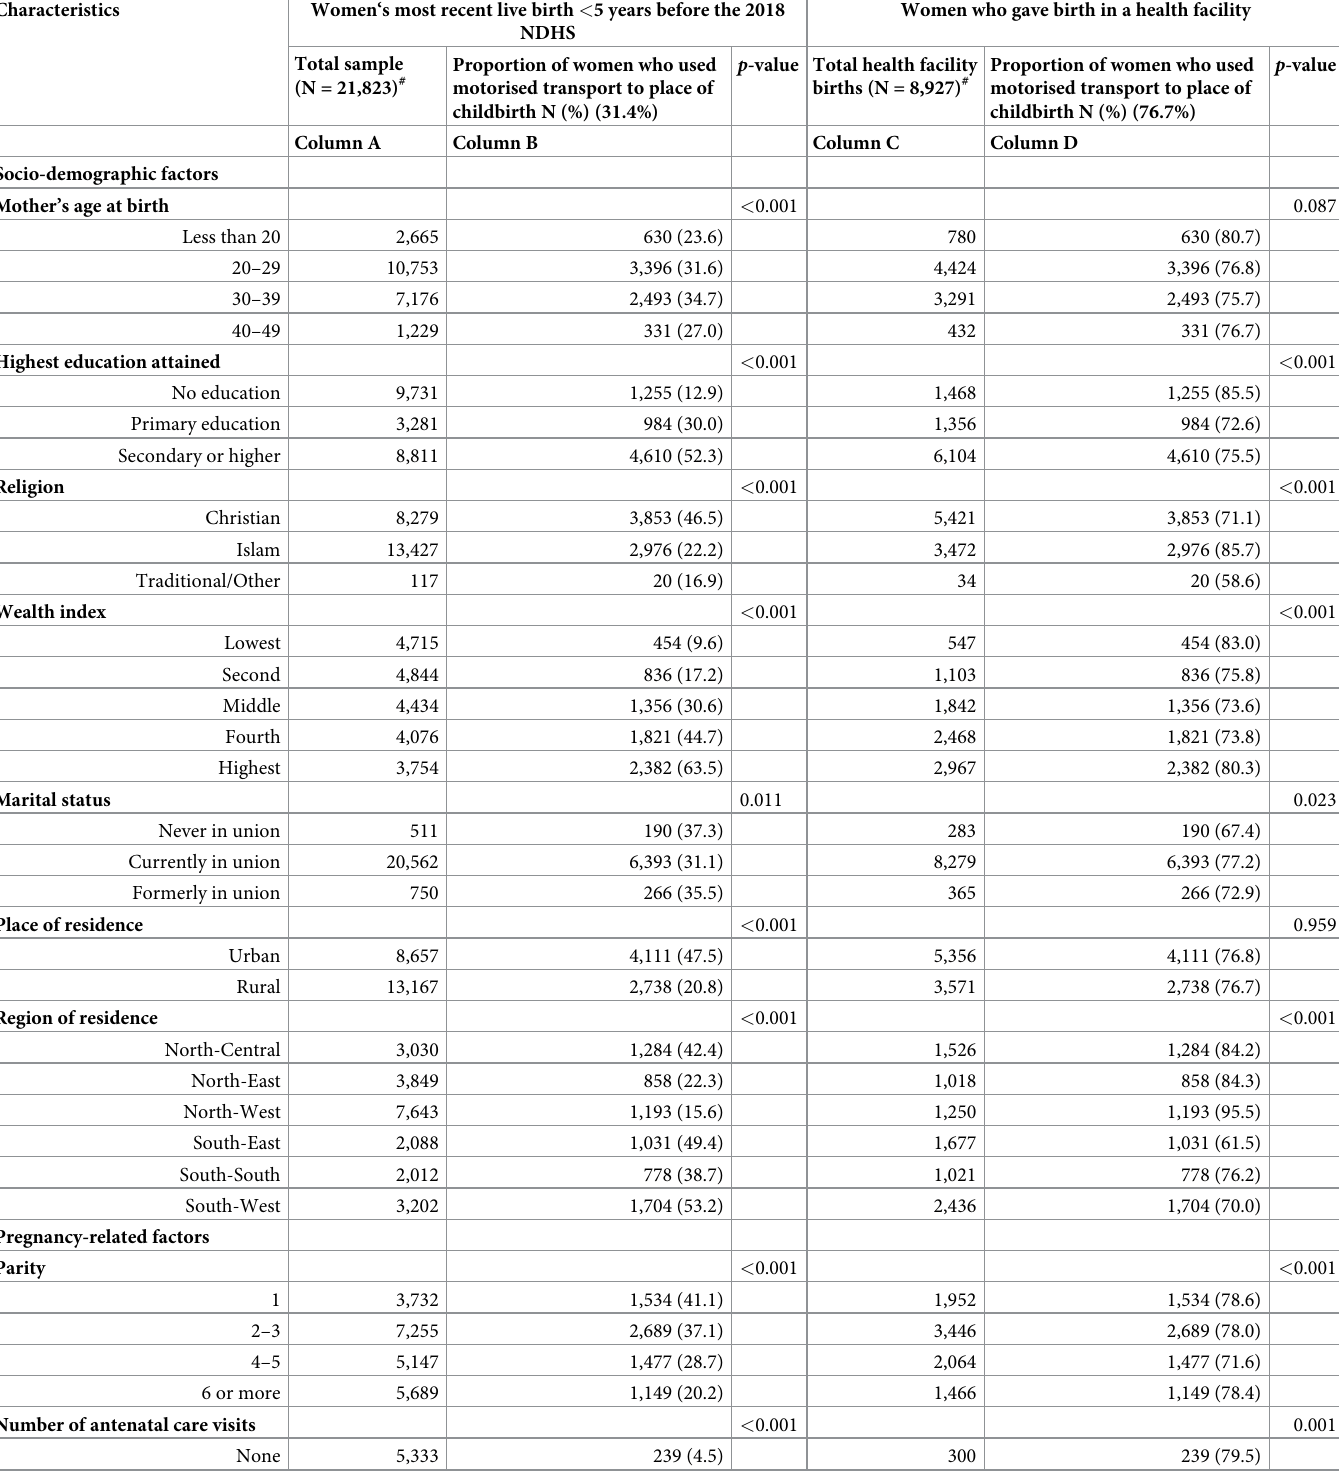
Table 2. Proportion of women who use motorised transport to facility of childbirth among all women and among women who gave birth in a health facility in the 2018 NDHS.